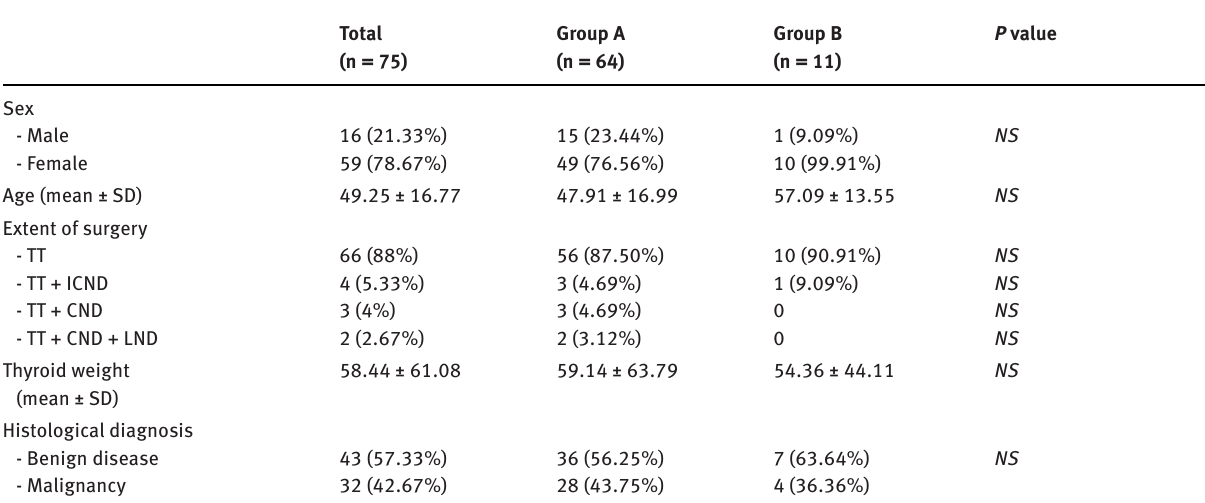
Table 1: Demographic data, information on surgical procedure and histopathological findings.